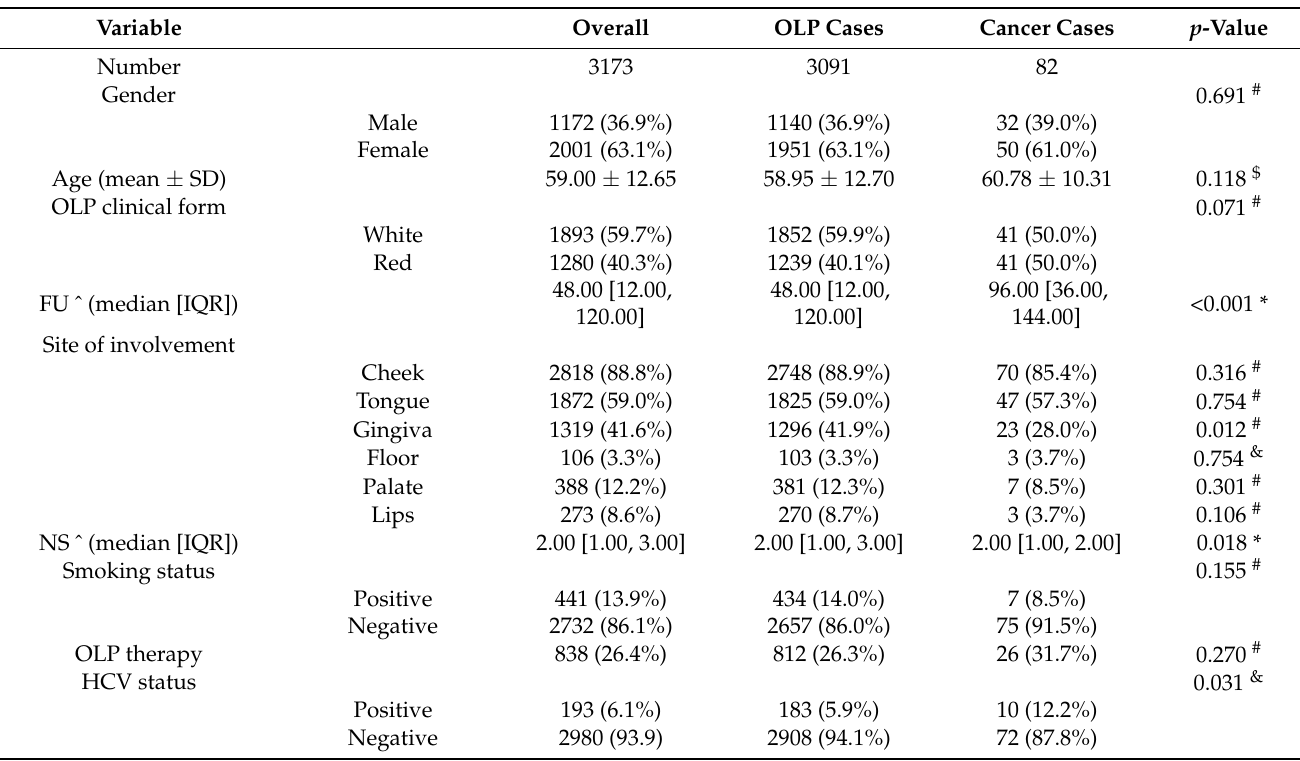
Table 1. Demographic and clinical features of studied